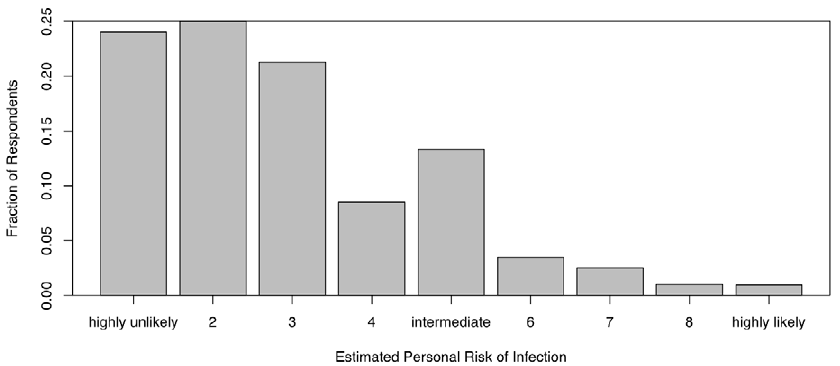
Figure 3. Frequency distribution of personal risk perceptions. While most respondents rate their personal risk as low, note the pronounced second mode at the intermediate level of risk perception.